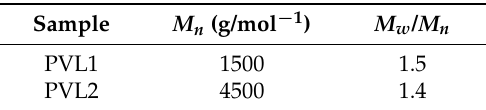
Table 1. The number average molecular weight ( M n ) and dispersity ( M w /M n ) of the poly( δ ‐ valerolactone) samples characteristics by GPC.